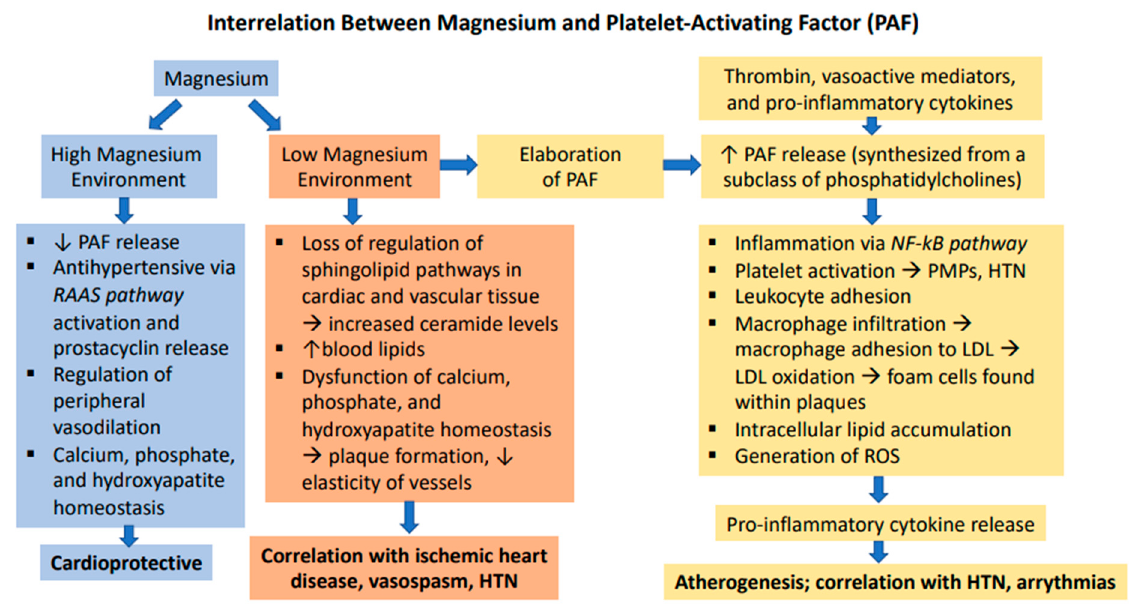
Figure 8. Interrelation between magnesium and platelet-activating factor (PAF).